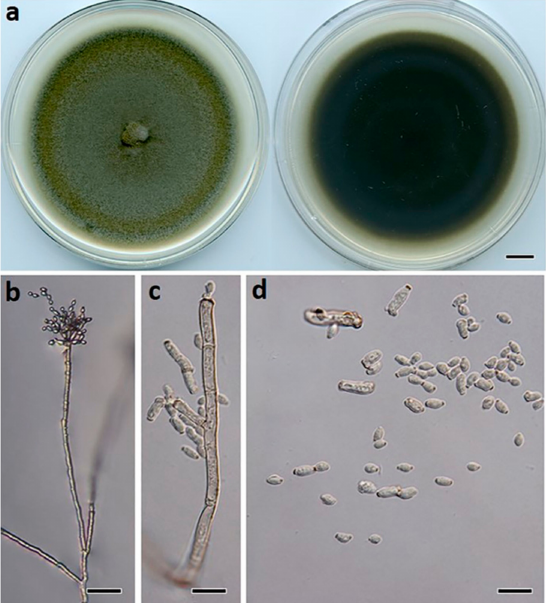
Figure 5. Cladosporium devikae (BRIP 72278a). ( a ) Two-week-old colony on PDA (upper surface and lower surface), ( b ) conidiophore, ( c ) ramoconidia, and ( d ) terminal conidia. Scale bars: ( a ) = 1 cm; ( b ) = 25 µ m; ( c , d ) = 10 µ